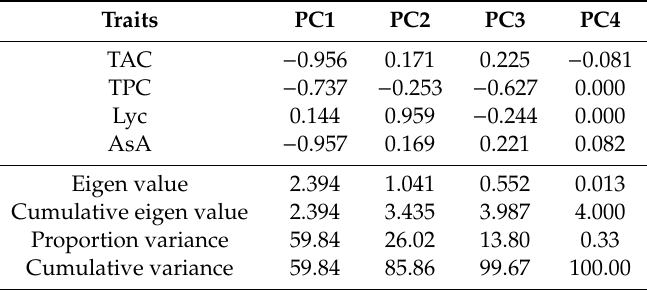
Table 6. Eigen vectors and eigen values of the first four principal components for quality traits of tomato